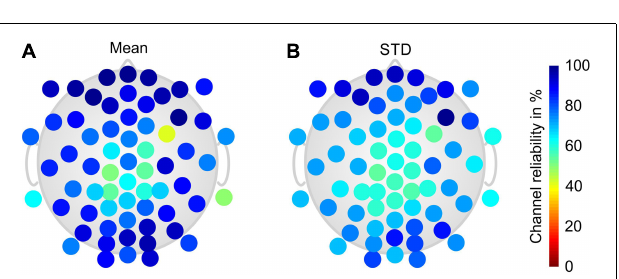
FIGURE 4 | Color-coded topographic plots of the relative channel reliability of the dry electrode cap, evaluated by two EEG experts and calculated over all volunteers and phases of the paradigm: (A) mean and (B) STD. Orientation of the topographic plot: nose on